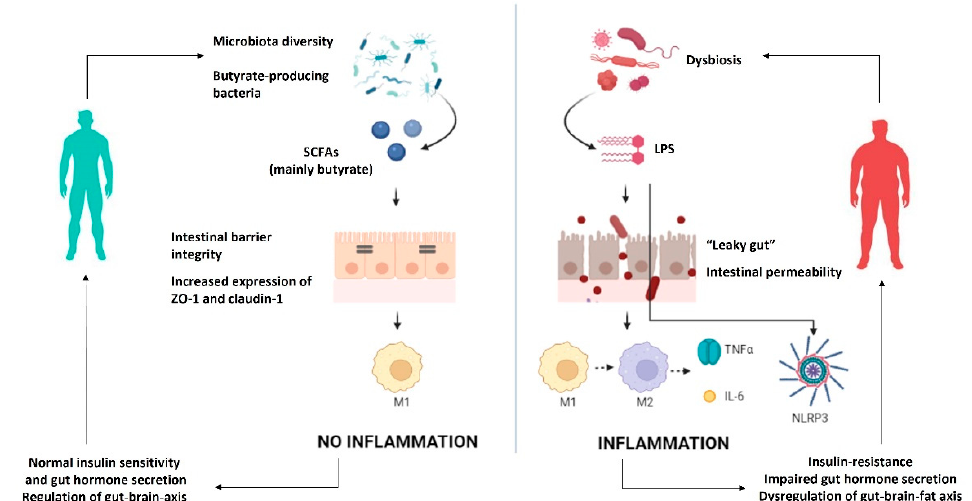
Figure 1. Mechanisms by which gut microbiota can modulate low ‐ grade inflammation and obesity. IL ‐ 6—interleukin 6; LPS—lipopolysaccharides; M1—macrophages M1; M2—macrophages M2; NLRP3—inflammasome; SCFA—short ‐ chain fatty acids; TNF α —tumor necrosis factor α ; ZO ‐ 1— zonulin.